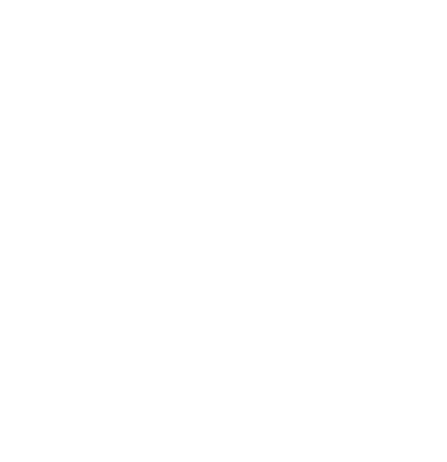
Table 2. Characteristics of the